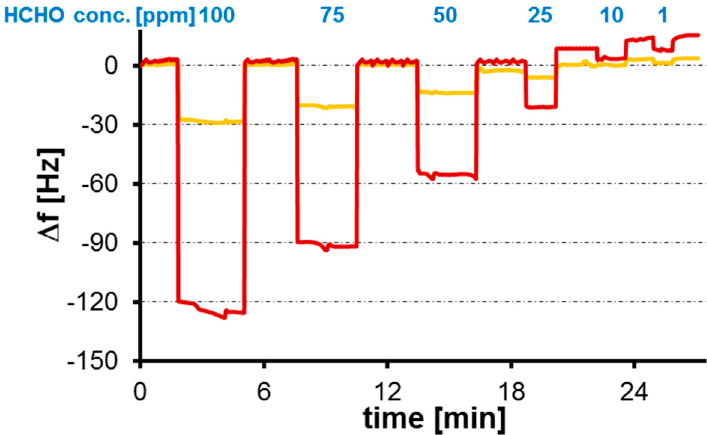
Figure 3. QCM sensor responses of molecularly imprinted polymer (MIP) and non-imprinted polymer (NIP), respectively, to pulses containing different vapor concentrations of formaldehyde.